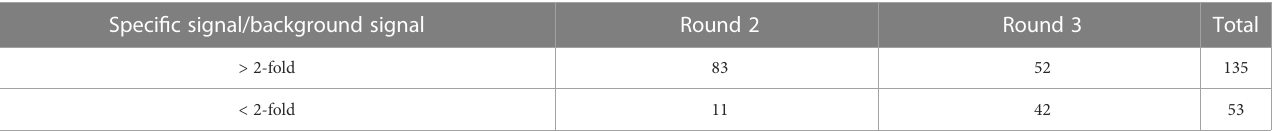
TABLE 3 PE-ELISA of individual colonies screened for binding to BFT1 from panning of round 2 and 3. Speci fi c signal/background signal Round 2